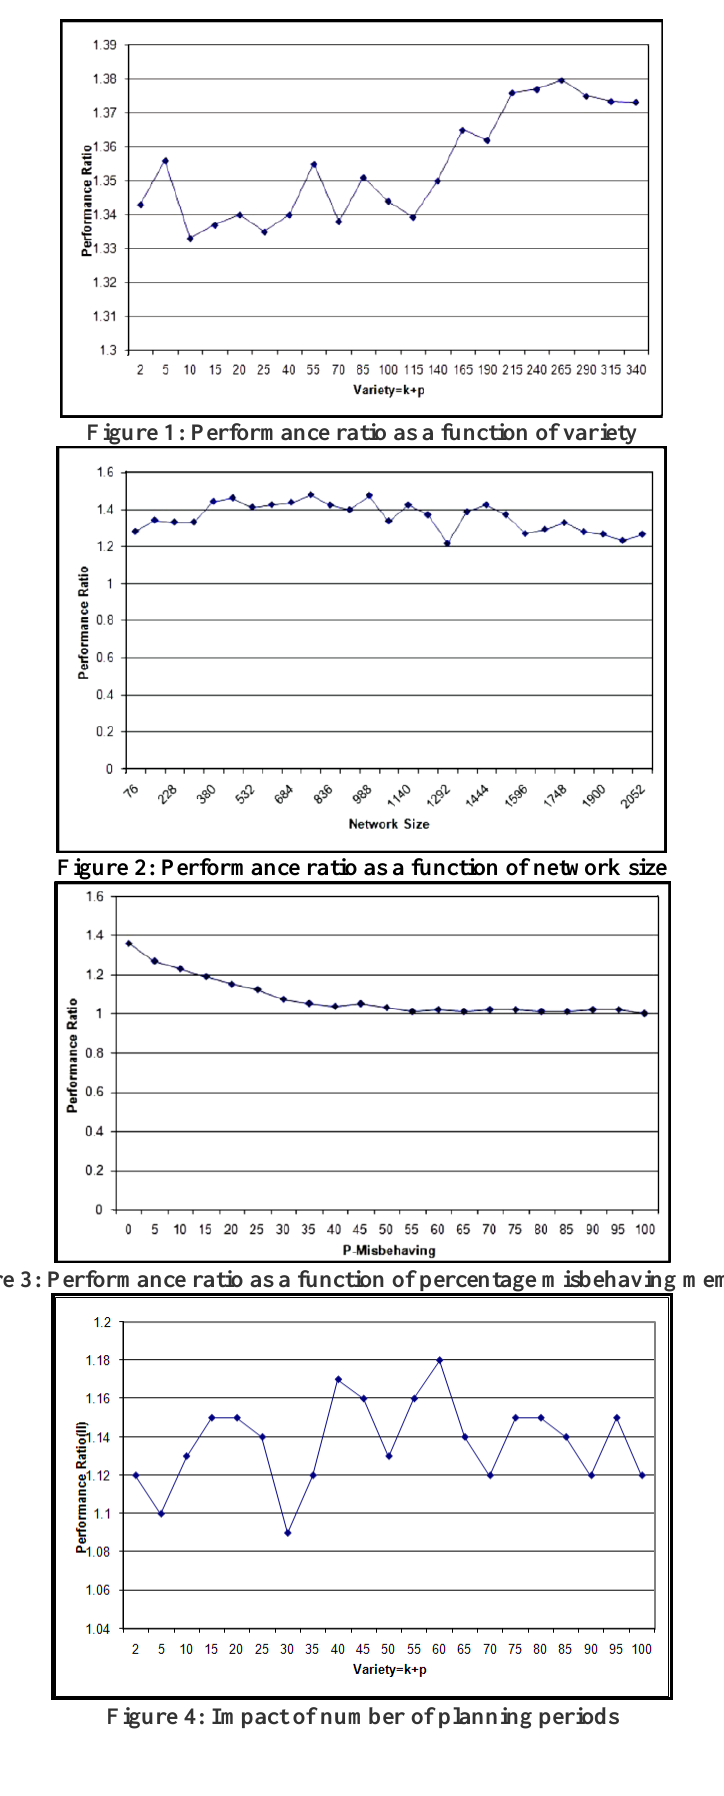
Figure 4: Impact of number of planning